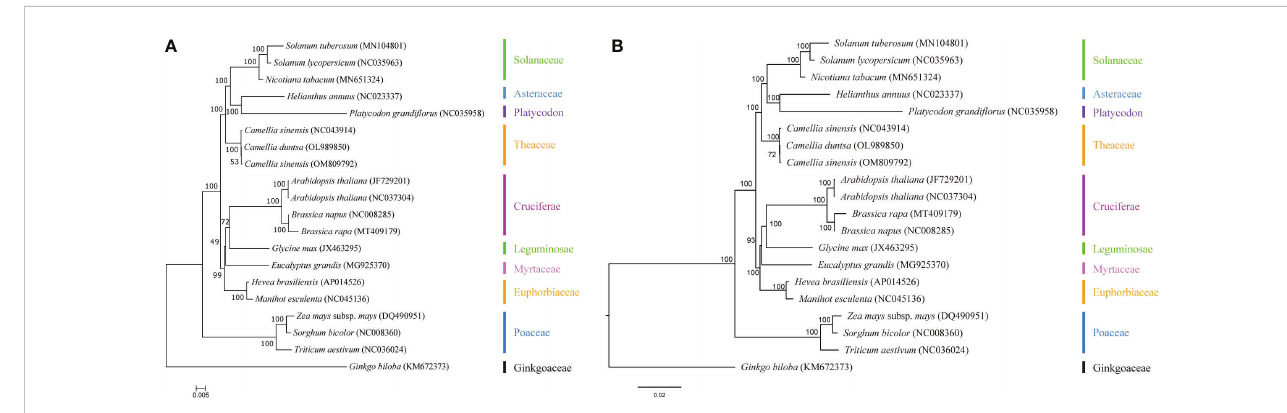
FIGURE 11 C .duntsa ’ s nineteen plant phylogenetic connections. Outgroup: Triticum aestivum , Sorghum bicolor , Ginkgo biloba , Zea mays . (A) Maximum-likelihood phylogenies. (B) Bayesian